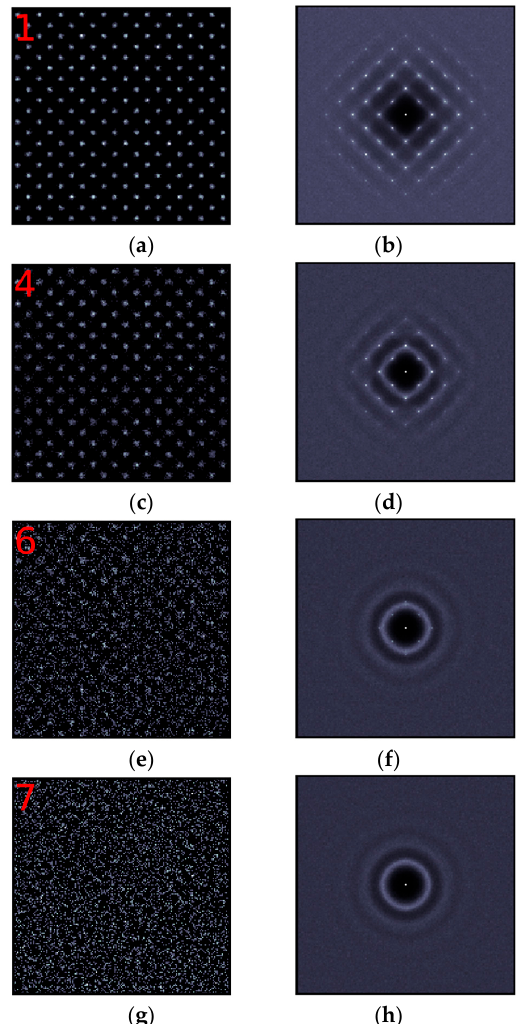
Figure 2. In ‐ plane ordering in the (100) interfacial layers. Left panel ( a , c , e , g ): 2 ‐ D density maps. The red numbers correspond to those defined in Figure 1. Right panel ( b , d , f , h ): 2 ‐ D structure factors for the corresponding layers.